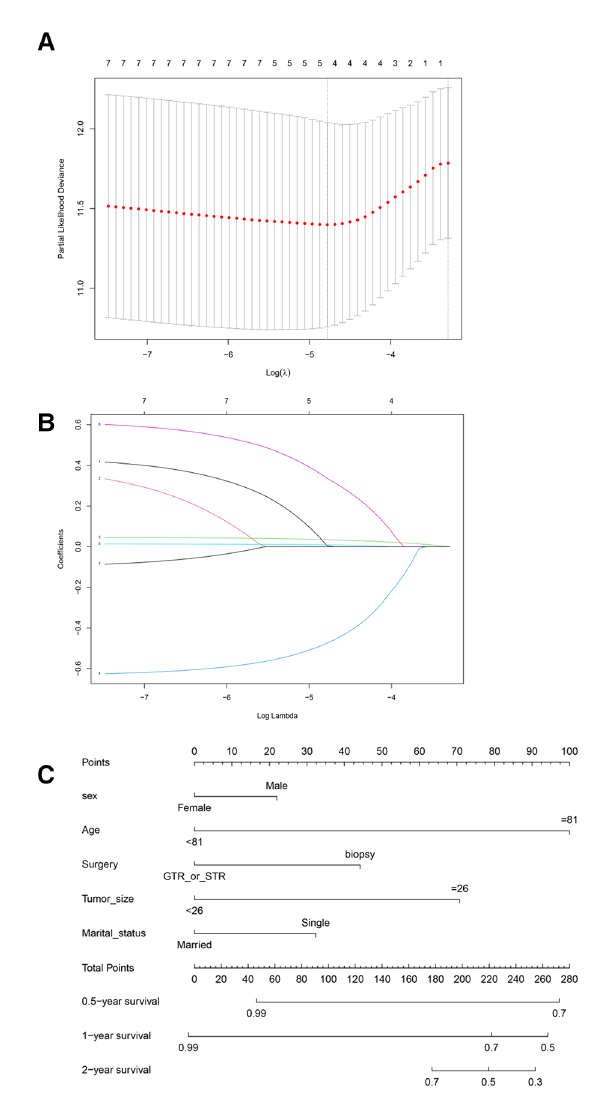
TABLE 1 Clinical characteristics of the patients with SM ( n =1,148).